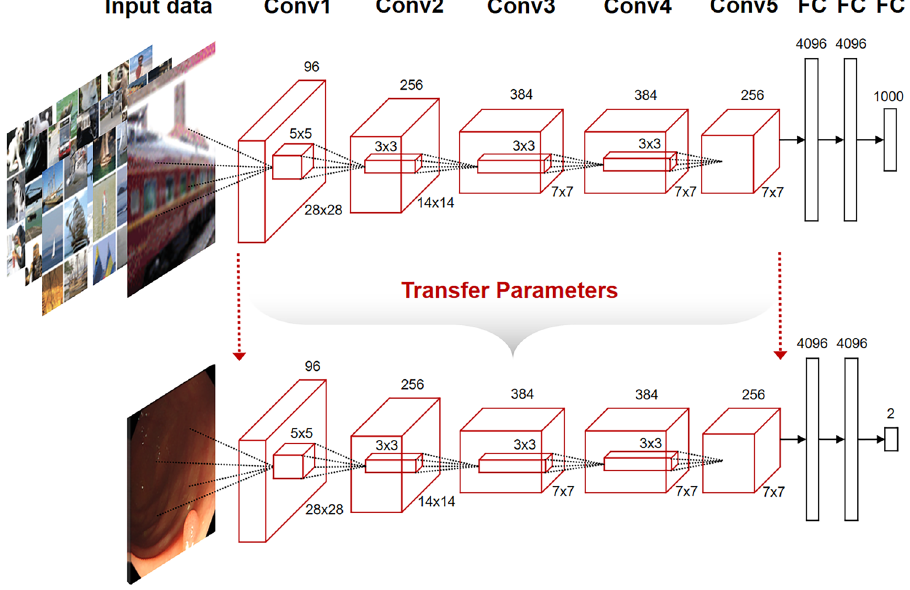
Figure 2. AlexNet structure of transfer learning from ImageNet database. The parameters are transferred in all layers from Conv1 to Conv5 except